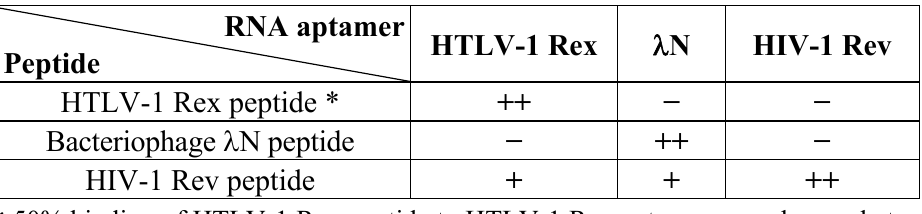
Table 2. Cross-reactivity between three RNA aptamer/peptide pairs. ( ++ , strong interaction; + , cross-reactivity; − , lack of